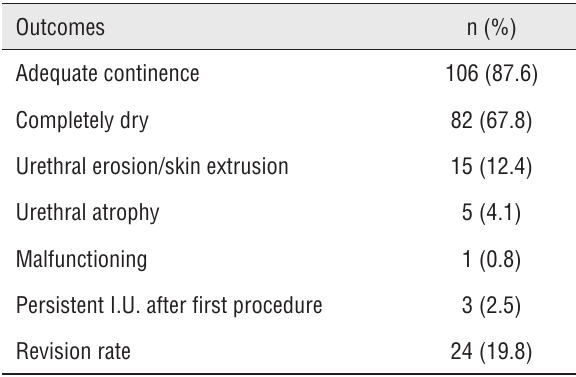
Table 1 - Outcomes of As placement at our institution from May 2001 to January 2016.